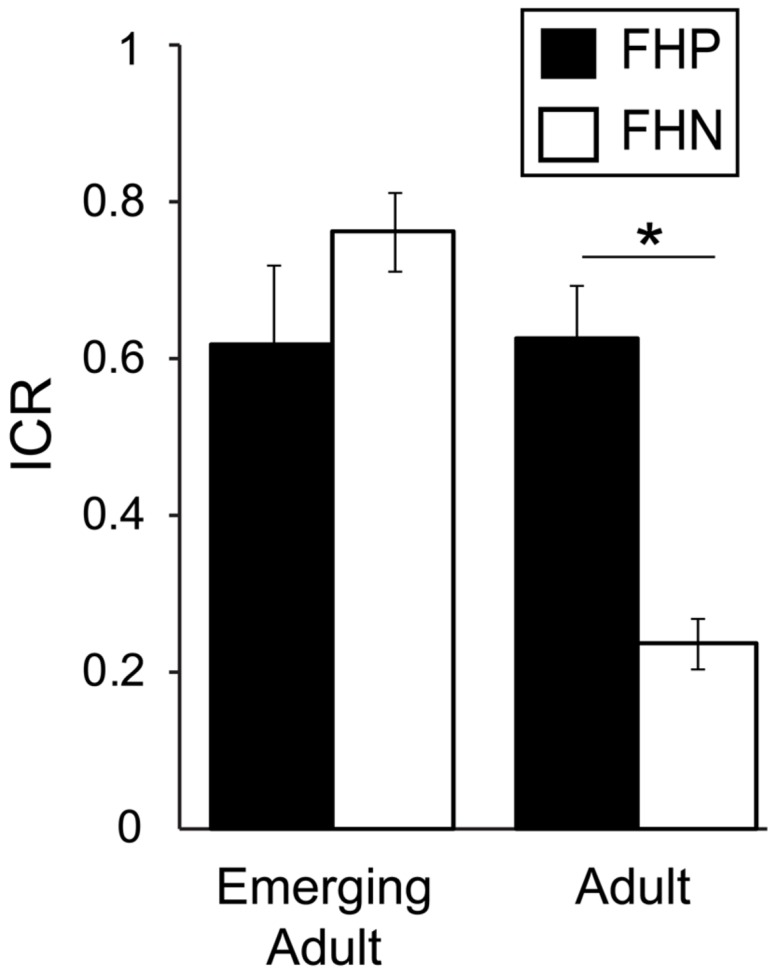
Family history (FH) of an alcohol use disorder (AUD) is associated with greater Now bias in non-heavy drinking adults but not emerging adults. Age group and FH had an interacting effect on ICR [F(1,50) = 16.40, p < 0.001, η2 = 0.203]. This interaction reflects dramatically higher ICRs among adults with a first degree relative with an AUD (FHP) relative to adults with no first degree relative with an AUD [FHN; F(1,12) = 7.21, p = 0.020, η2 = 0.366] and a smaller, opposing trend effect of FH among emerging adults [F(1,37) = 3.89, p = 0.056, η2 = 0.092]. ∗p < 0.05.